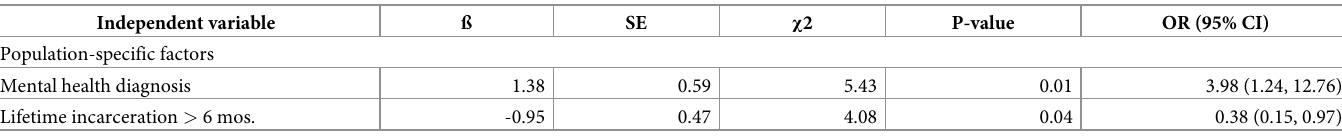
Table 6. Logistic regression model for dependent variable cervical cancer diagnosis, N = 290 a .